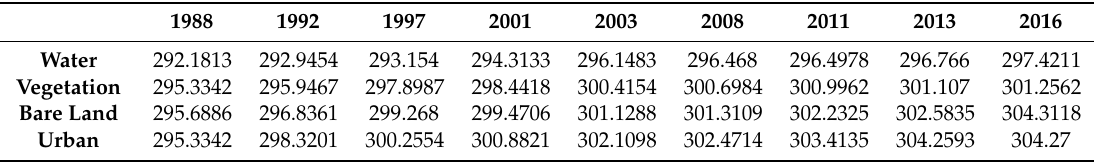
Table 3. Mean Land Surface Temperature for corresponding urban land covers (in